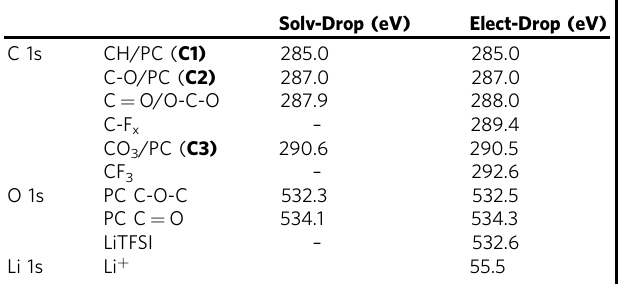
Table 1 Overview of assigned peaks and their respective binding energy positions in the curve fi ts of C 1s, O 1s, and Li 1s spectra from Solvent drop (Solv-Drop), and Electrolyte drop